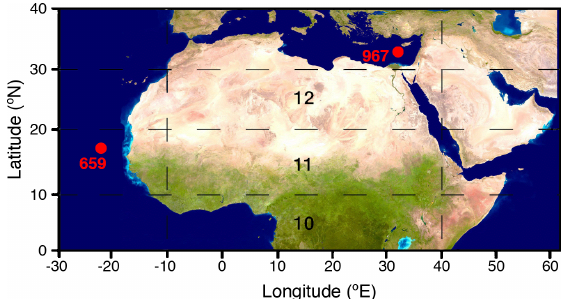
Figure 1. Map of the study area, with the background showing veg- etation cover. Dashed lines indicate the grid boxes of CLIMBER-2, with the number the grid boxes used in this study. Red dots indicate the location of the